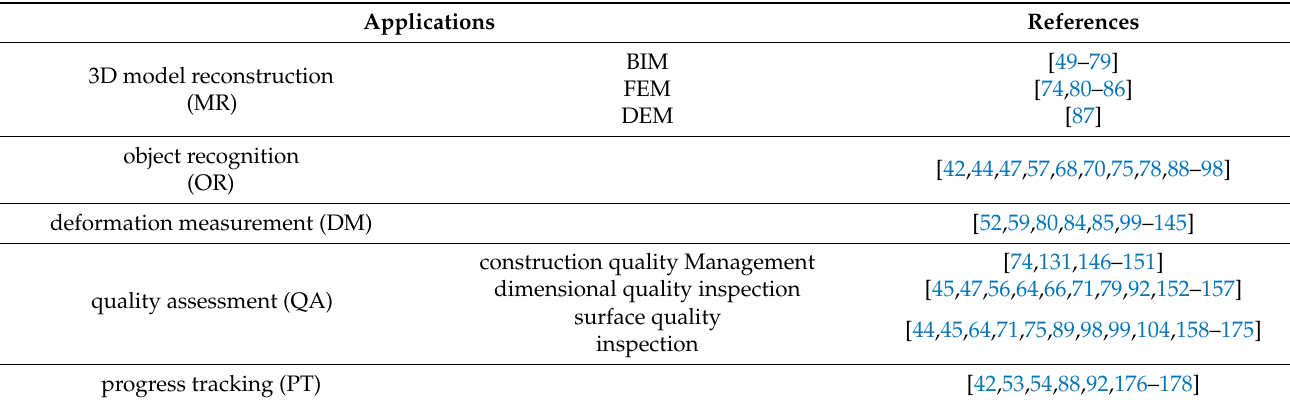
Figure 7. Distribution of applications of TLS in the AEC industry. Table 5. Summary of applications of TLS in the AEC